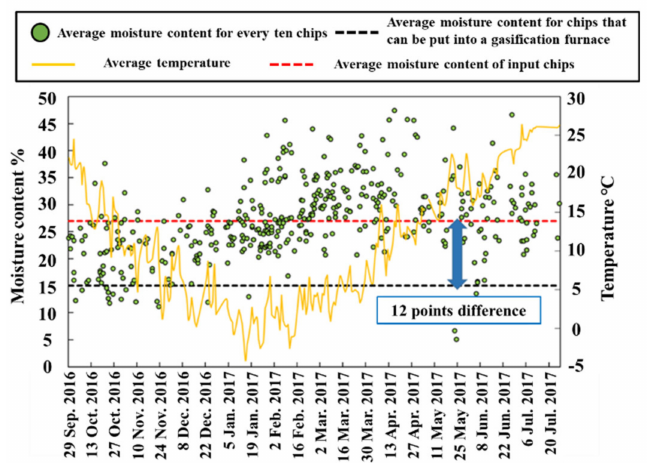
Figure 9. Moisture content of wood chips inside the storage hopper (from 29 September 2016 to 26 July 2017). Reprint with permission; JSME, 2020 [19].